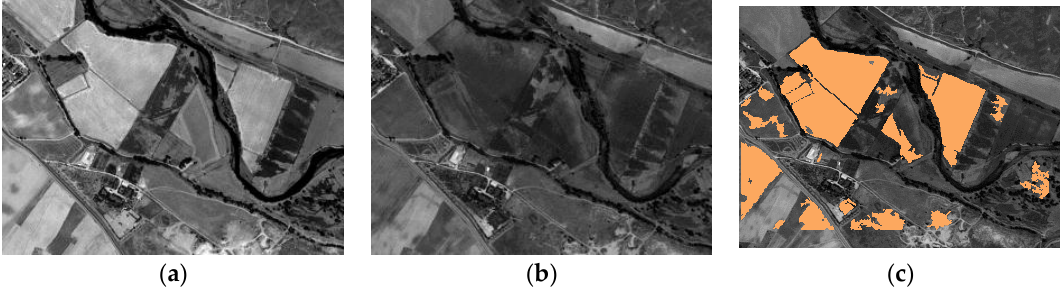
Figure 16. DS1 subset example for object based analysis: ( a ) 2005 SPOT-PAN image subset; ( b ) 2008 SPOT-PAN image subset; ( c ) Test objects.